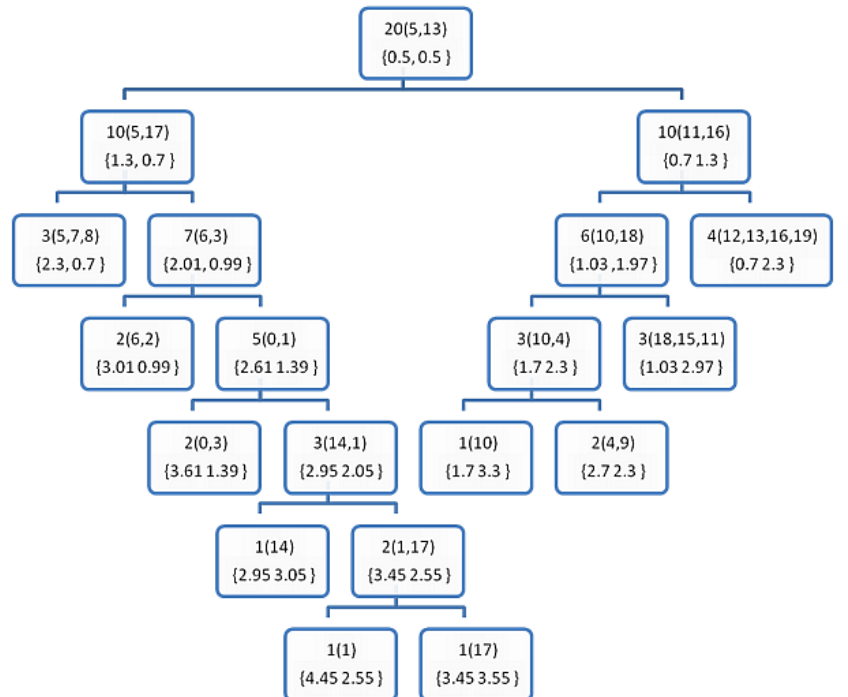
Figure 3. The resultant decision tree after applying the training phase of the DT0 on the sample data from Table 1. The number outside the rounded brackets () is the counter of the examples hosted by each node, and those inside the rounded brackets are the index of the examples in a leaf node, or the furthest points (P1 and P2) otherwise. The numbers in the curly brackets {} shows the probabilities of the classes at each node.